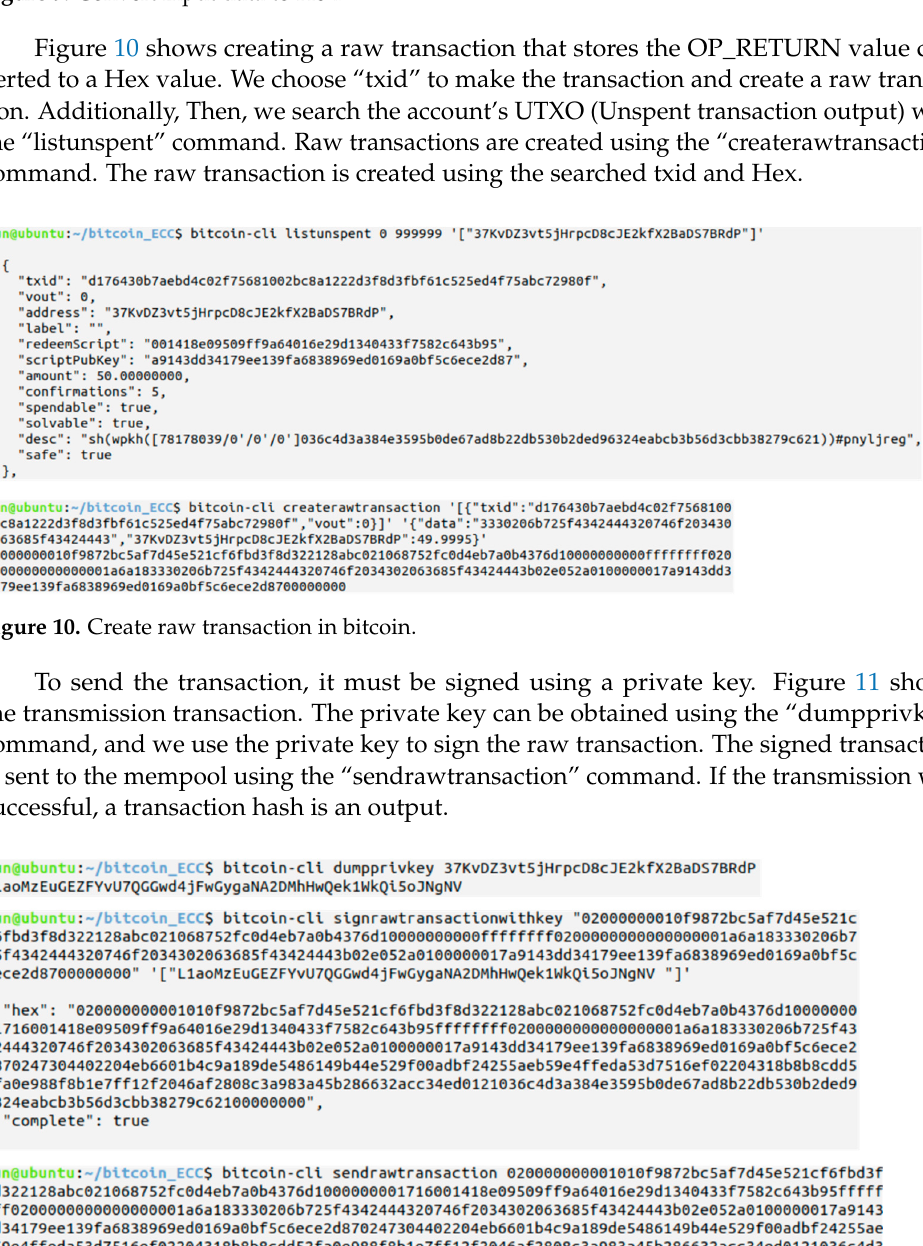
Figure 9. Convert input data to Hex.